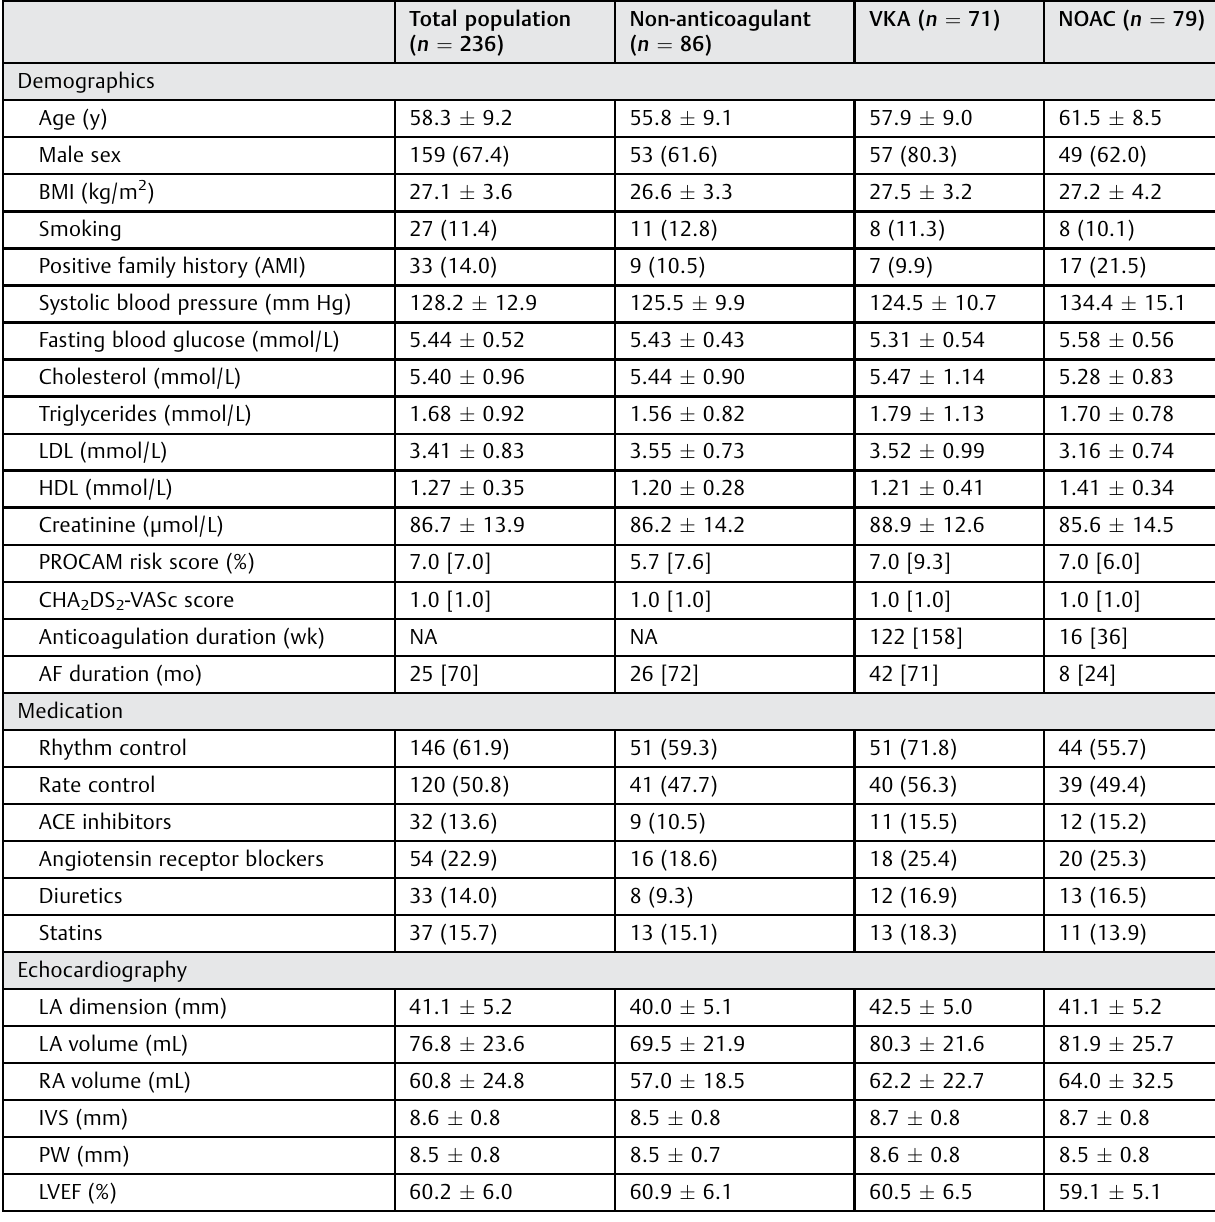
Table 1 Baseline characteristics of the total population